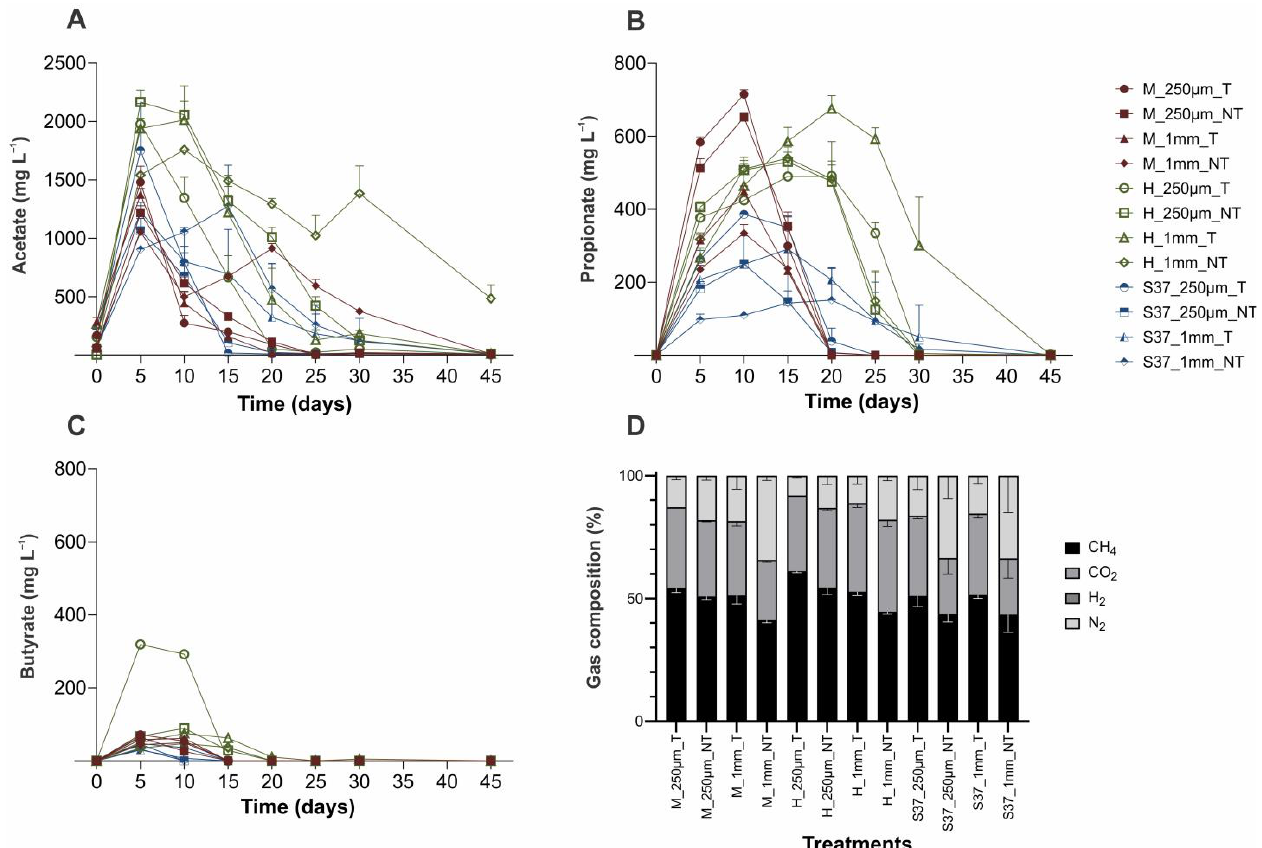
Figure 2. Volatile fatty acids concentration over 45 days of cultivation. ( A ) Acetate; ( B ) Propionate; ( C ) Butyrate. ( D ) Gas concentration at 30 days of cultivation. The error bars represent the standard deviation of the mean of n = 3 (invisible error bars are smaller than the symbol).